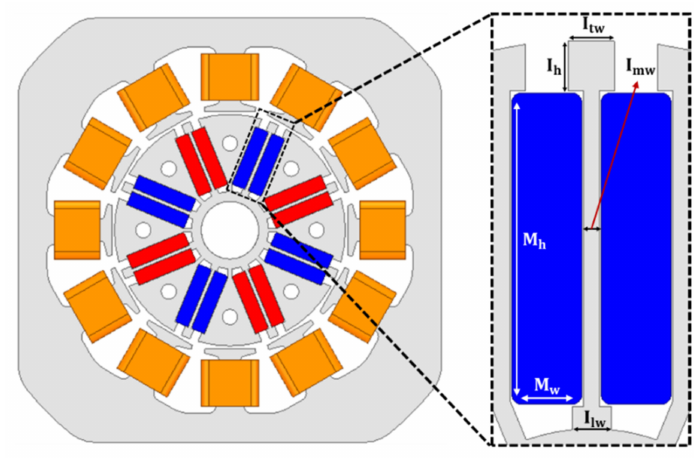
Figure 4. Basic design of I spoke-type PMSM.